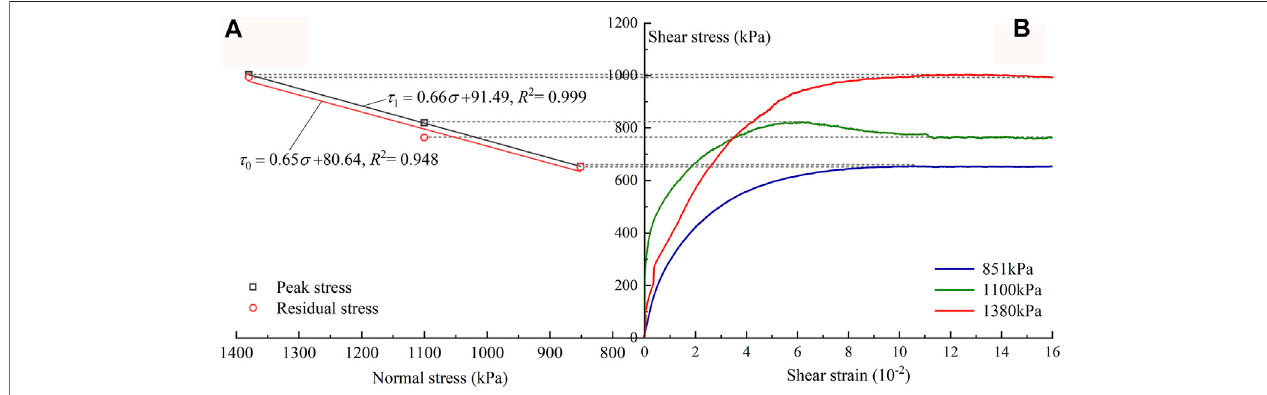
FIGURE 5 | Results of direct shear tests. (A) Fitting curves of peak stress and residual stress, (B) Stress-strain curves under different normal stresses.